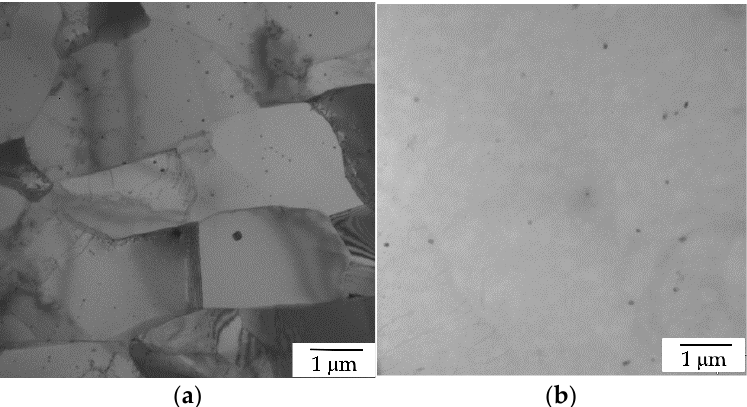
Figure 7. TEM image of the AlYb CR70 alloys after isochronal treatment ( a ) up to 360 ◦ C—see secondary Al 3 Yb particles inside (sub)grains; ( b ) up to 540 ◦ C—see secondary Al 3 Yb particles. Microhardness HV0.1 and relative resistivity changes of the as-cast and cold rolled AlMnYbZr alloys after isochronal treatment are presented in Figure 8. Insignificant changes were observed in the as-cast AlMnYbZr alloy due to the isochronal treatment. The microhardness values of the cold rolled state with reduction of 40% and 70% are comparable (in the accuracy of measurement). The positive effect of cold rolling on microhardness changes was observed until treatment at 390 ◦ C (hardening is approximately 30%), after that in the temperature interval 390–450 ◦ C microhardness values slowly decrease and reach the same values (in measurement accuracy) as in the AlMnYbZr AC alloy up to the end of the ageing. The trend of the isochronal ageing curves of microhardness and hardening effect caused by cold rolling until 390 ◦ C ( ∆ HV0.1 ≈ 10) are the same for the AlYb and AlMnYbZr alloys. Other results [4,23] showed that the addition of Zr to Al alloys forms secondary particles, which strongly inhibit recrystallization. Therefore, we assume that, in contrast to the AlYb alloy, the decrease in microhardness in the cold rolled AlMnYbZr alloys in the temperature interval 390–450 ◦ C is probably caused only by the recovery of dislocations and/or the recovery of the dislocation structure. This assumption was also verified by EBSD in the as-cast AlMnYbZr alloy, where no change in grain size was observed even after 144 h of ageing at 350 ◦ C in contrast to the AlYb AC alloy after the same ageing procedure—see Figures 1, 6 and 9. In the relative resistivity curves of AlMnYbZr alloys, a decrease of resistivity was observed in the temperature interval 330–540 ◦ C (labelled as I-stage) followed by an increase of resistivity (II-stage). More significant changes and even a double decrease in relative resistivity changes (Ia and Ib-stages) were observed in cold rolled AlMnYbZr